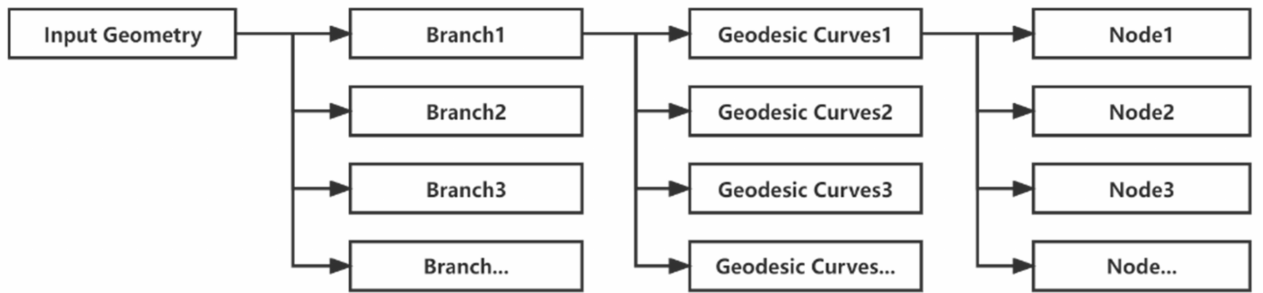
Figure 2. Hierarchical framework of printing node